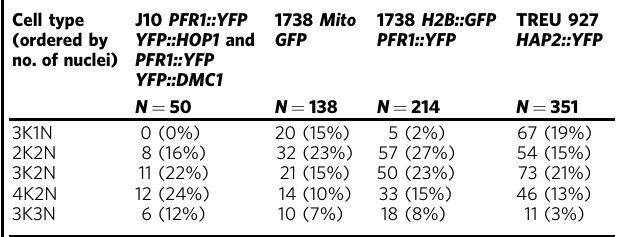
Table 1 Morphology of predominant types of meiotic intermediates among salivary gland-derived trypanosomes of T. b. brucei .